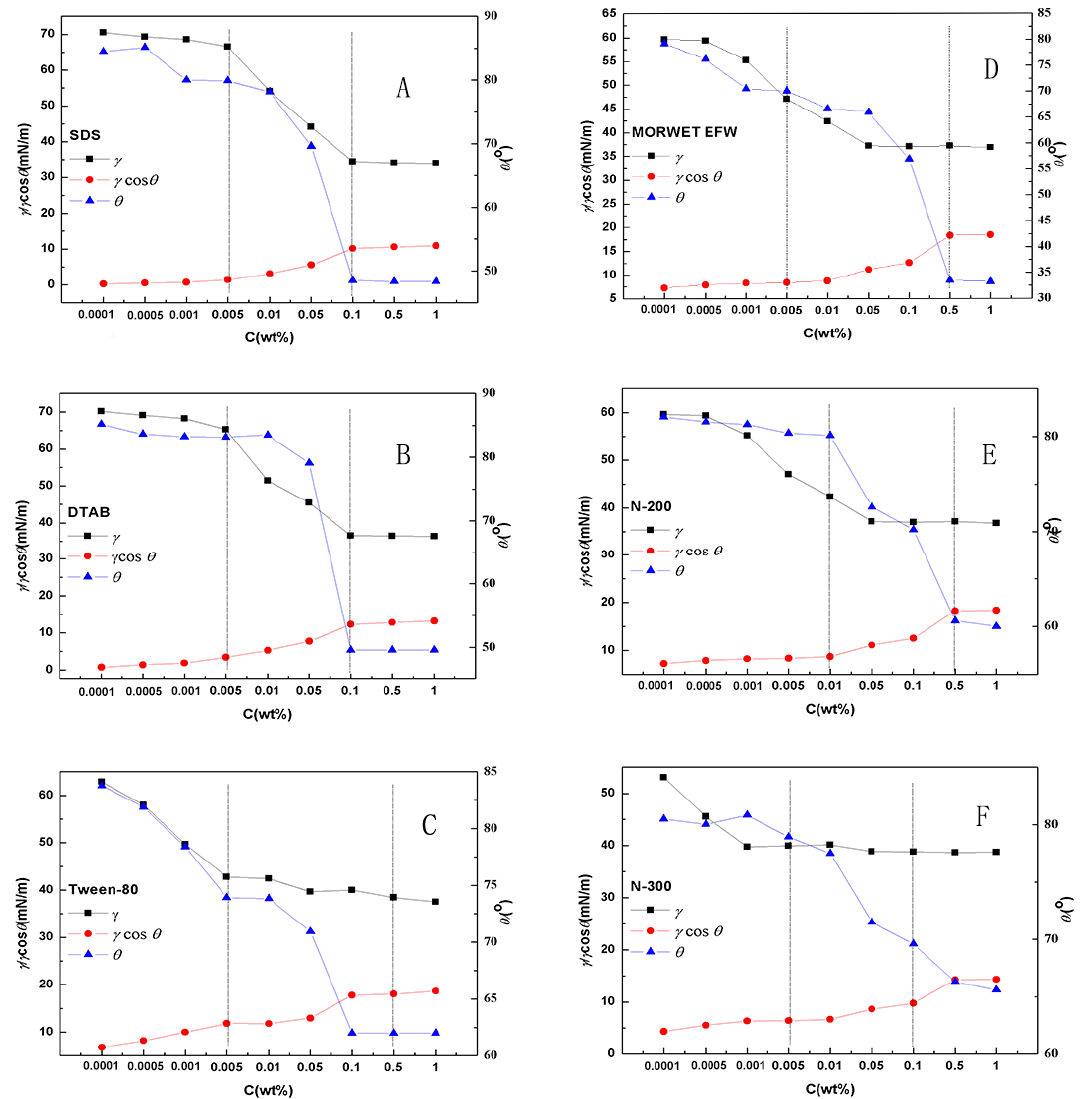
Figure 8. Dependence of the adsorption data of SDS ( A ), DTAB ( B ), Tween-80 ( C ), Morwet EFW ( D ), N-200 ( E ), and N-300 ( F ) on tea leaf surfaces.